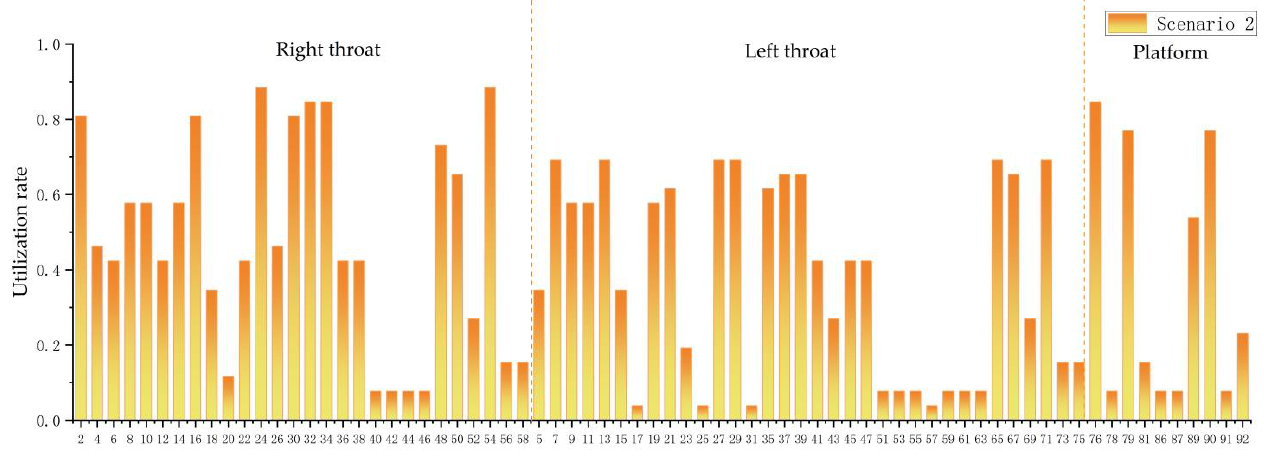
Figure 9. Utilization of switches and platforms in scenario 2.